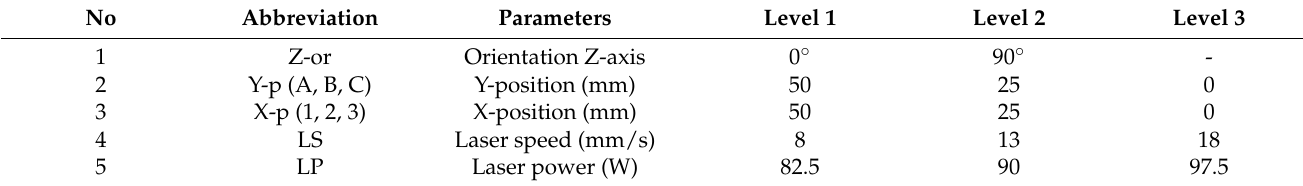
Table 1. Parameters with levels.